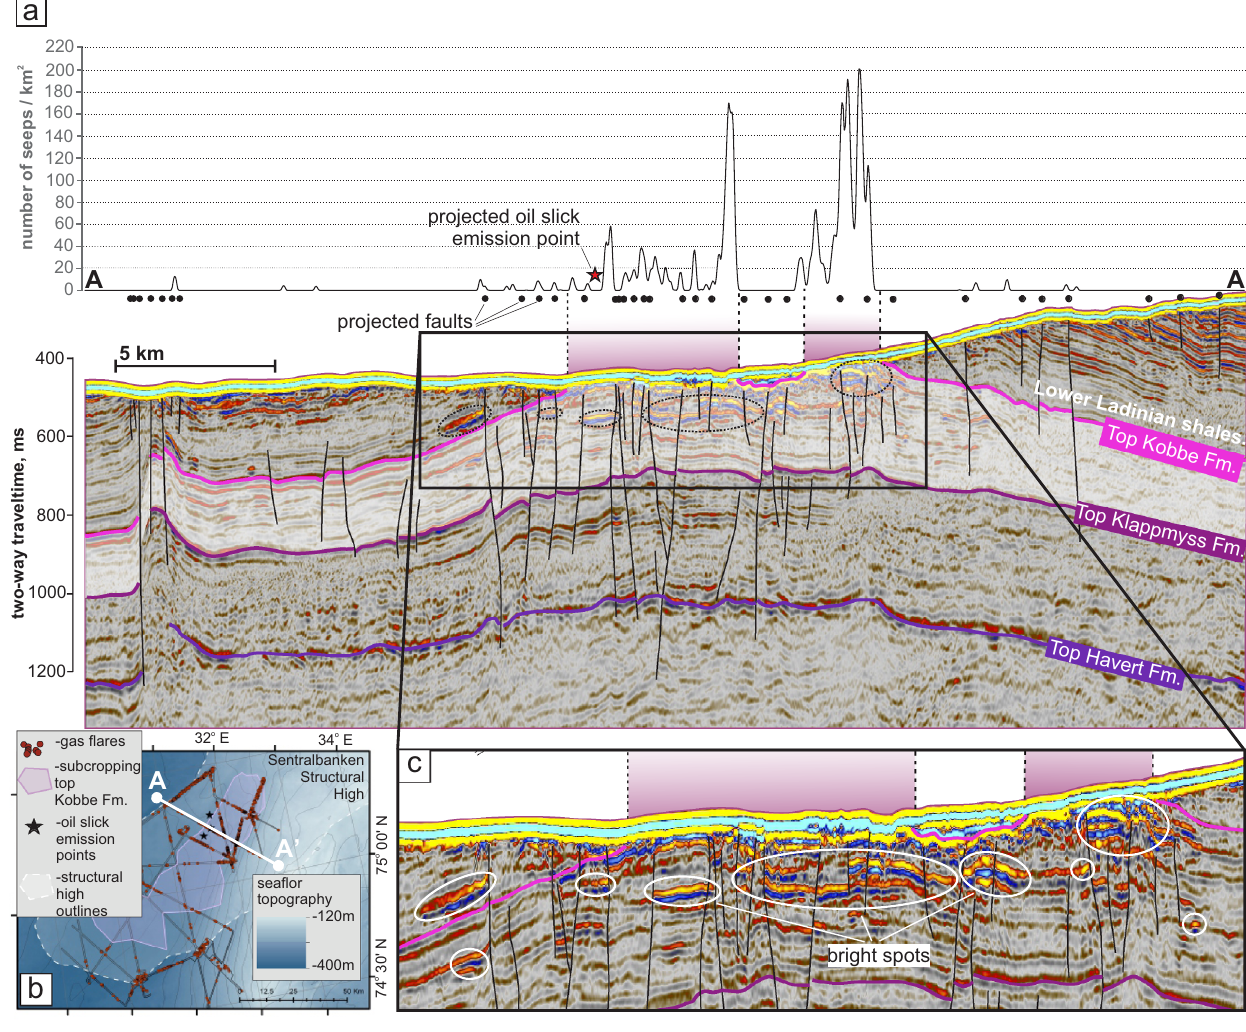
Fig. 6 | Correlationofgas release and subcroppingreservoir Kobbe Formation and faults. a Seepage density, faults and subcropping Kobbe Formation along transect A - A ’ . White shading shows the reservoir. Black subvertical lines show